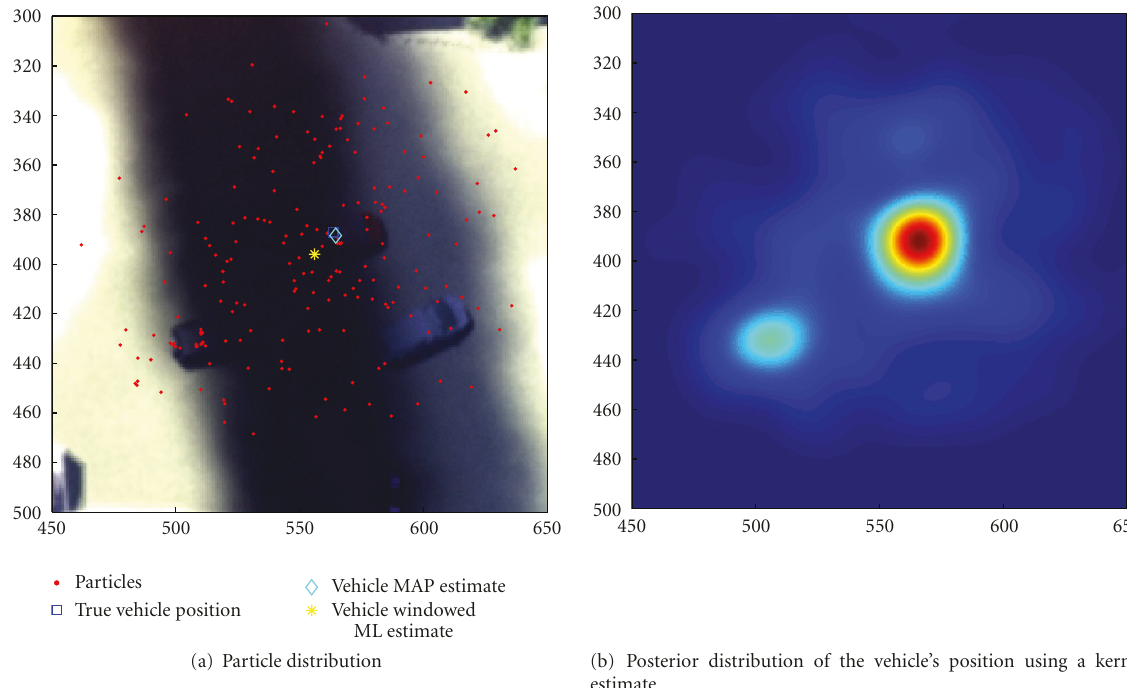
Figure 8: These figures show the particle distribution, as well as the corresponding kernel estimate of the posterior distribution at video frame